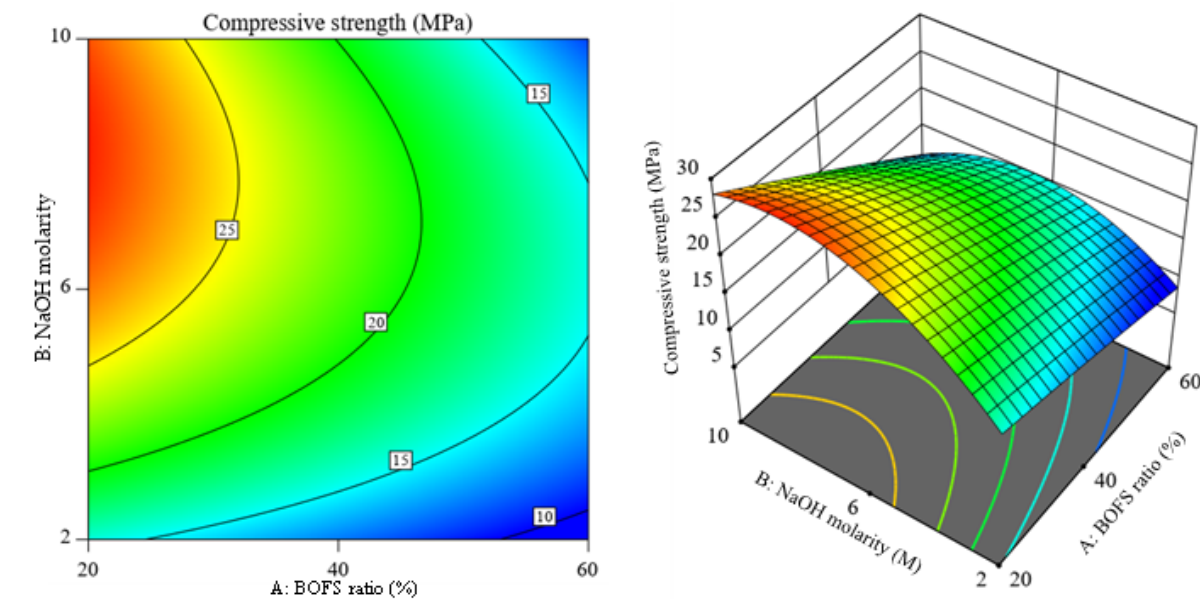
Figure 14. Contour plot and 3D response surface of 28-day compressive strength.